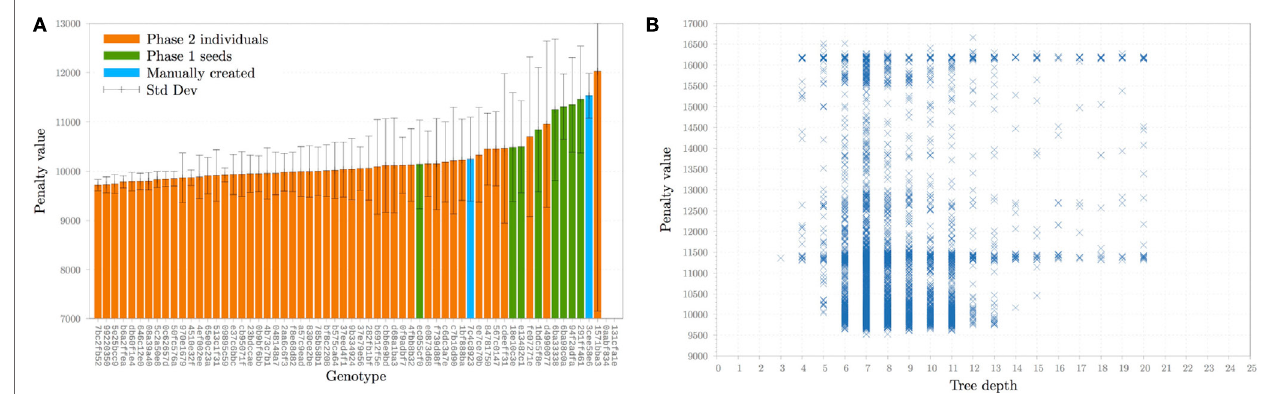
FigUre 7 | (a) Penalty ranking of evolutionary experiments. (B) Penalty values vs. syntax tree depth in the second phase of evolutionary experiments. Both figures © von Mammen et al. (2016) CC BY-NC-SA